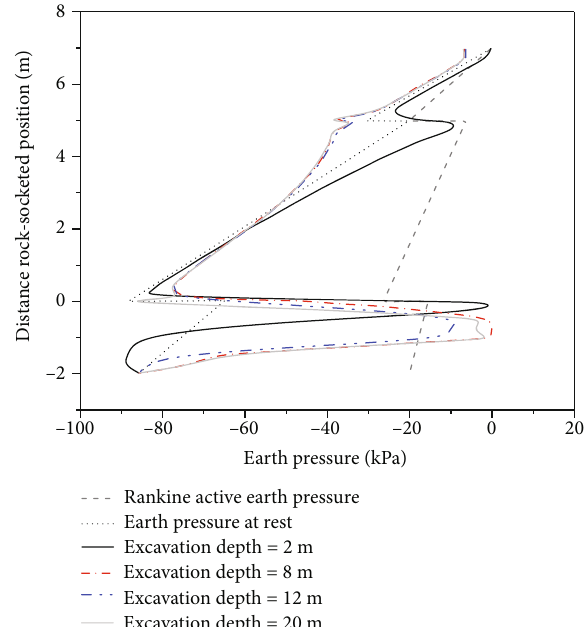
Figure 16: Earth pressure applied on the active side of the end- suspended pile at di ff erent excavation stages.